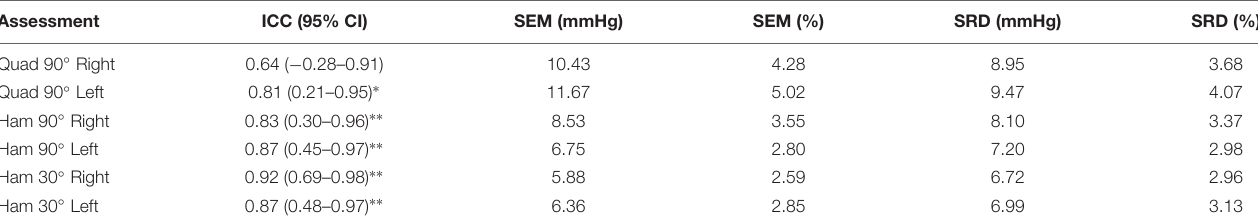
TABLE 1 | Test–retest reliability of the adapted sphygmomanometer tests between two separate assessment visits.